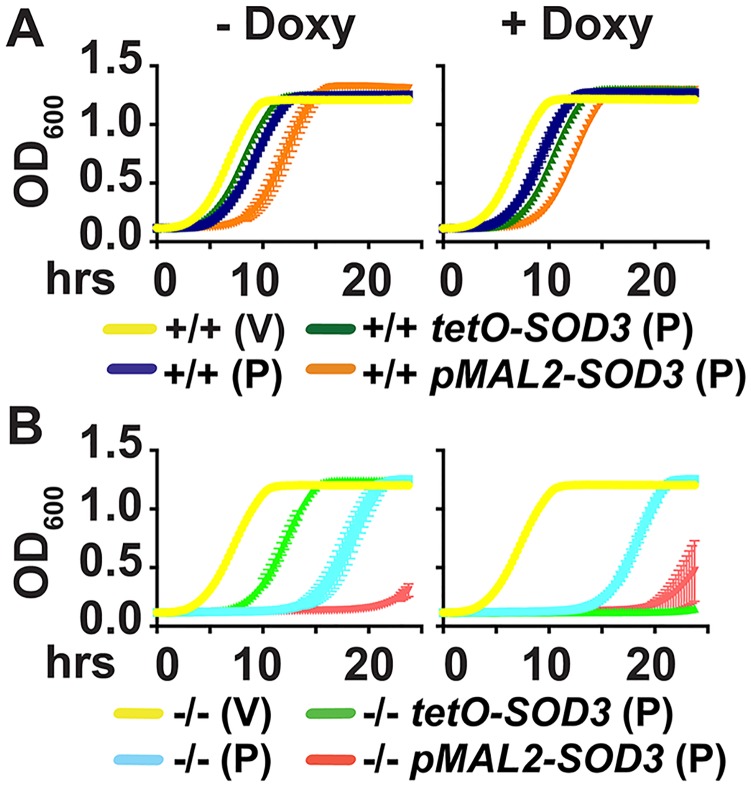
Overexpression of SOD3 from a heterologous promoter significantly rescues ROS hypersensitivity of cells lacking Pho84.Cells were grown on YPD agar medium without or with 50 ng/ml doxycycline for 39 hrs, and were maintained in these doxycycline concentrations throughout the course of the experiment. Cells were inoculated at OD600 0.1 in YPD (glucose-containing medium that represses transcription from pMAL2), with vehicle DMSO (V) or 21 μM Plumbagin (P). OD600 was monitored every 15 minutes for strains (A) wild type background: +/+, JKC915; +/+ tetO-SOD3/SOD3, JKC1738; +/+ pMAL2-SOD3/SOD3, JKC1776; (B) pho84 null mutant background: -/-, JKC1450; -/- tetO-SOD3/SOD3, JKC1745; -/- pMAL2-SOD3/SOD3, JKC1780. A, B are representative of 3 biological replicates, error bars SD of 3 technical replicates.